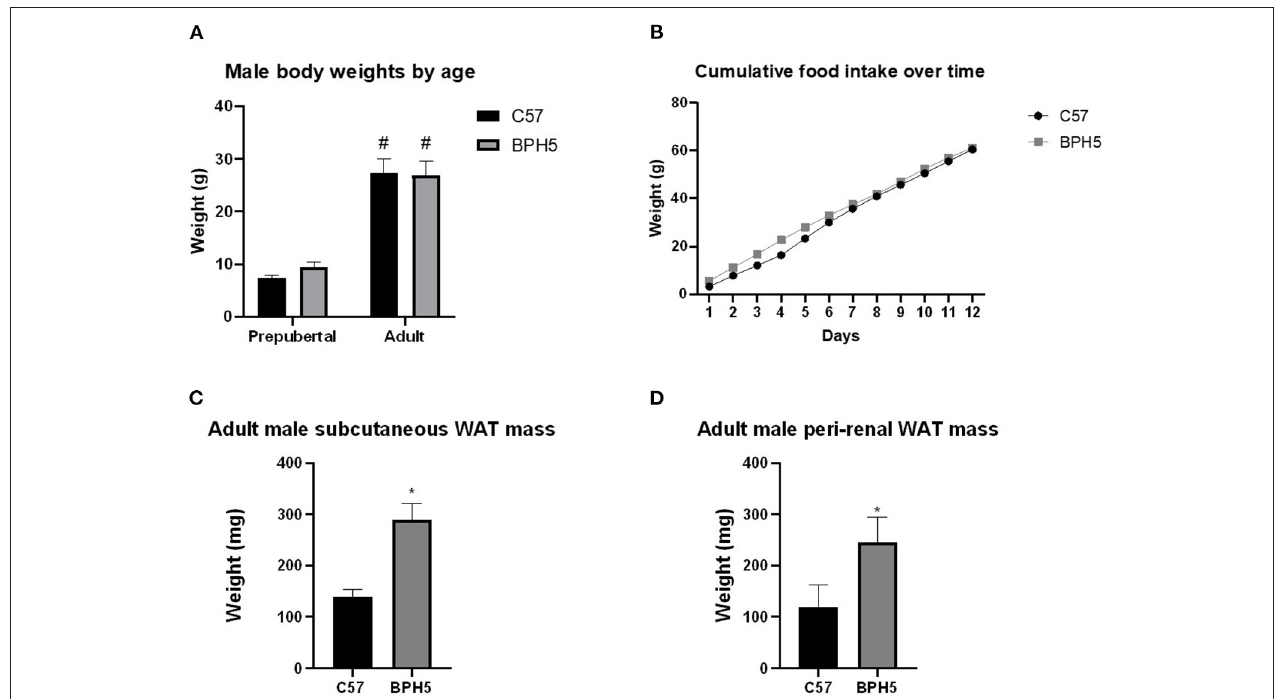
FIGURE 1 | Adult BPH/5male phenotypic differences in body weight, food intake, and white adipose tissue (WAT). (A) Body weights were measured in prepubertal and adult BPH/5 males, and a similar weight was demonstrated at both prepubertal and adulthood when compared to C57 males ( n = 10–32/group). (B) Daily and cumulative food intake was measured for 12 days in both BPH5 and C57 male and was found to be not significantly different ( n = 5/group). (C) BPH5 males have significantly increased subcutaneous WAT ( n = 6–18/group). (D) BPH/5 males have more peri-renal WAT vs. C57 ( n = 8/group) ( * p < 0.05 vs. C57, # p < 0.05 vs. prepubertal weights of their respective